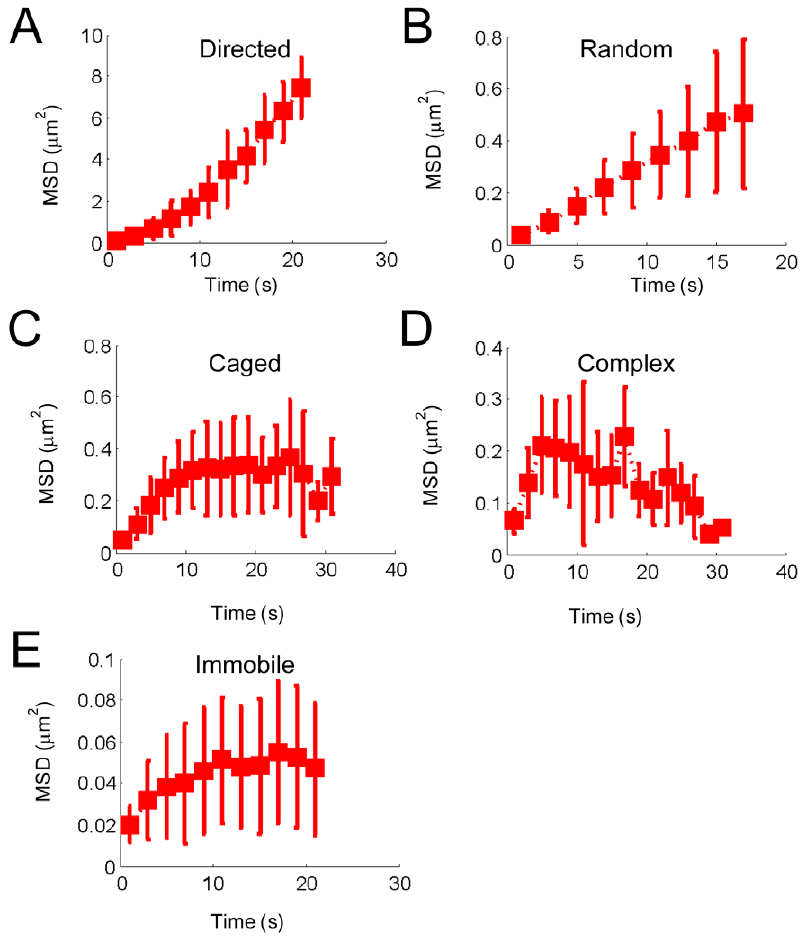
Figure 6. Three-dimensional mean square displacement (MSD) plots of each type of movement. Averages of all 3D-MSD plots from 32 control cells are shown for trajectories showing directed (A), random (B), caged (C), and complex (D) movement, as well as immobile vesicles (E) (see Materials and Methods). Note that the scales among the plots differ.